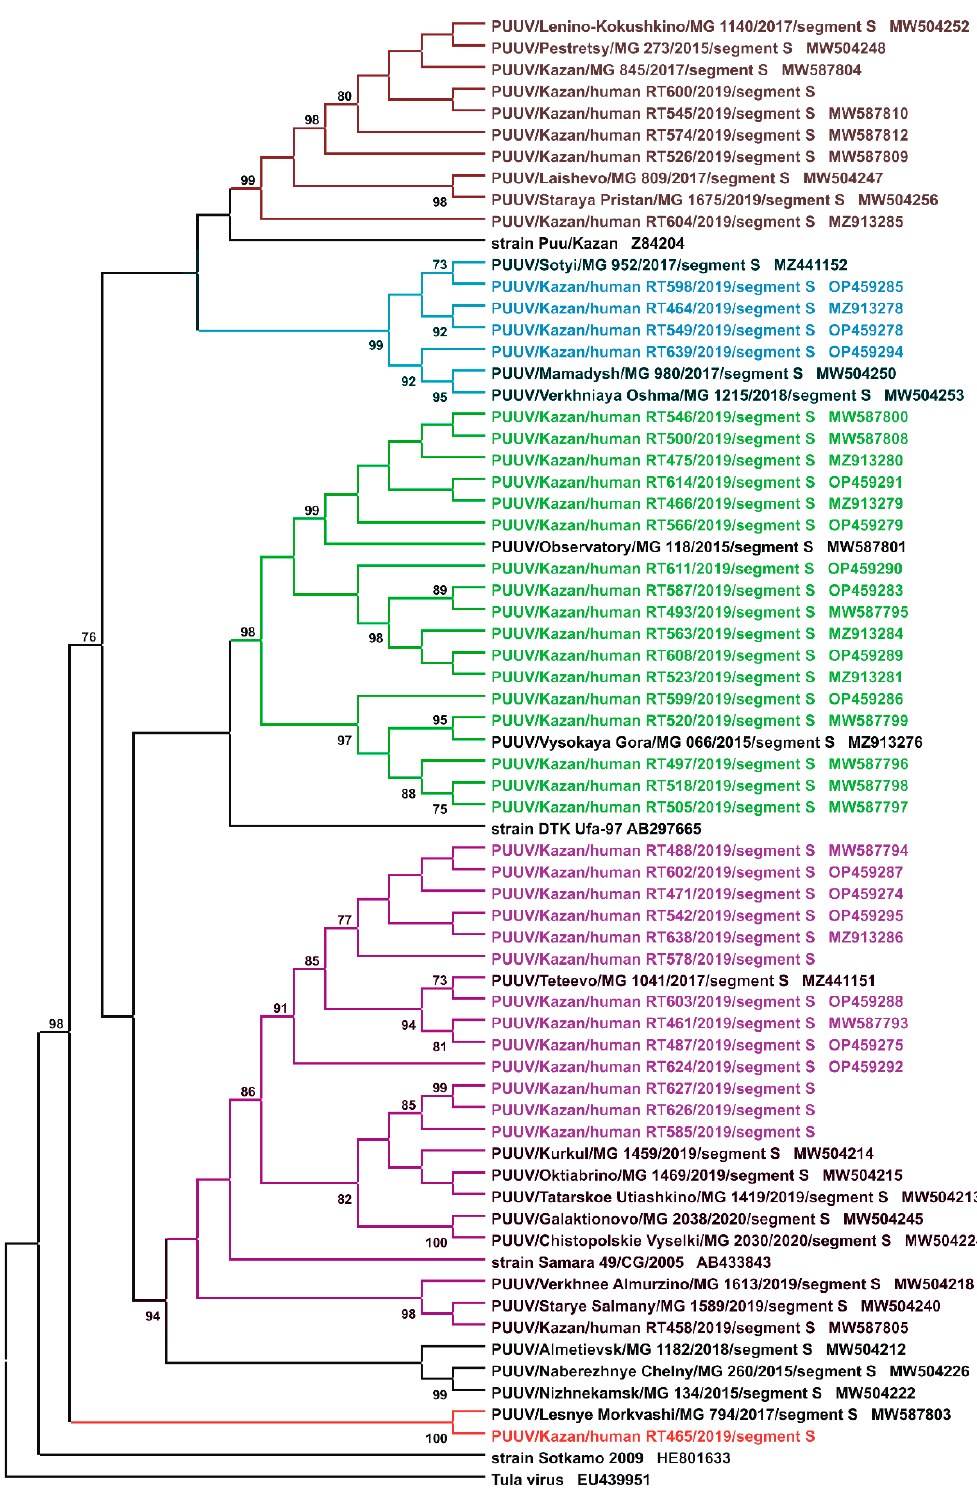
Figure 2. Phylogenetic tree. Sequencing and phylogenetic analysis of PUUV strains from humans and rodents.